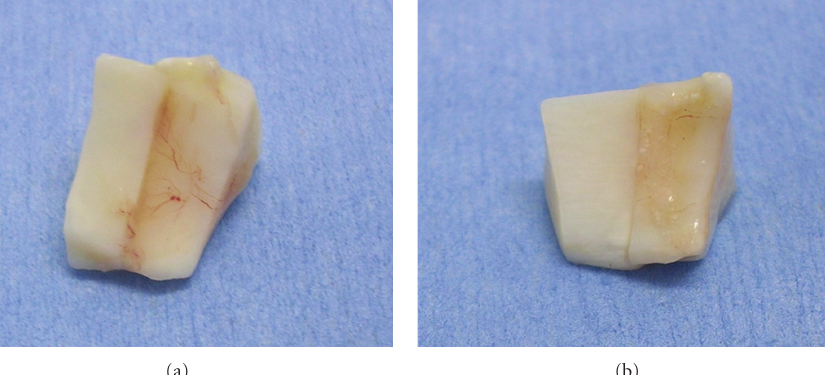
Figure 1: (a) Multiple vessels externally adhered to Group 1 meniscal construct. The vessels can be seen entering the cut area between the two sections. (b) Group 0 construct with minimal evidence of vessels on only one